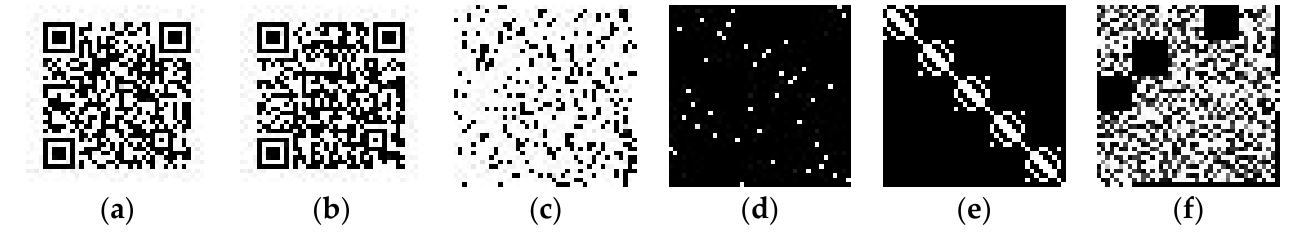
Figure 11. QR code reconstruction from tampered share ( a ) 5th QR code, ( b ) 6th QR code, ( c ) S 1 (5th QR code), ( d ) S 2 (5th QR code), ( e ) S 3 ( 6th QR code), ( f ) reconstructed QR code.